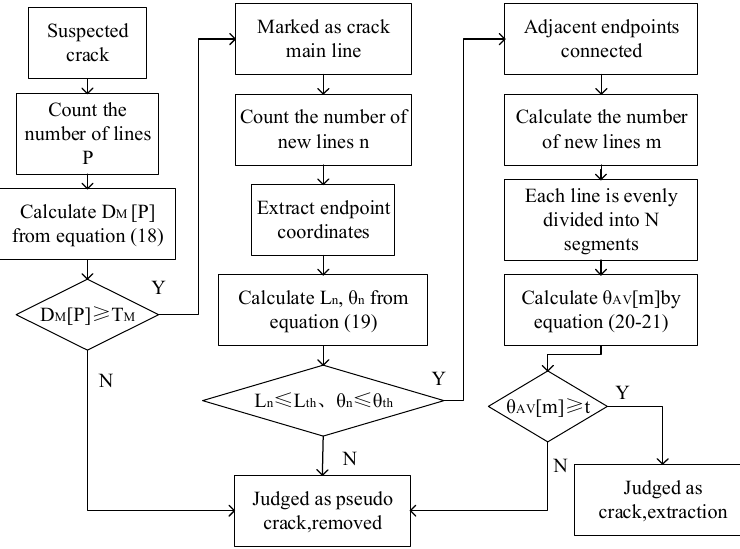
Figure 6. Crack extraction flow chart.